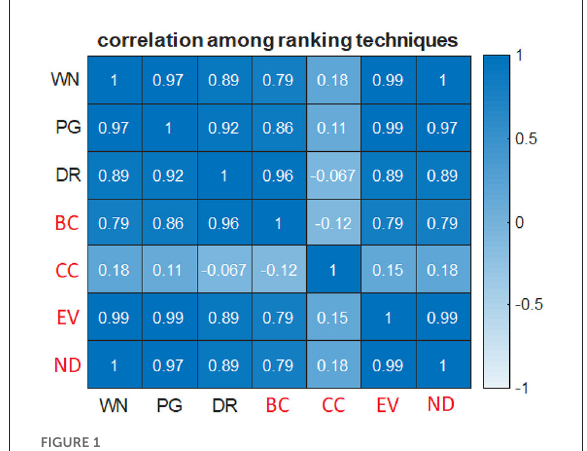
FIGURE1 WINNER gene prioritization is well-correlated with other ranking techniques and most network topological metrics. Genes in the KEGG AD pathway were ranked via WINNER (WN), PageRank (PG), Dual Node-edge Rank (DR), Betweenness Centrality (BC), clustering coefficient (CC), eigenvector centrality (EV), and node degree (ND); then, the correlation coefficients for all pairwise comparisons between ranking methods were calculated via Pearson’s